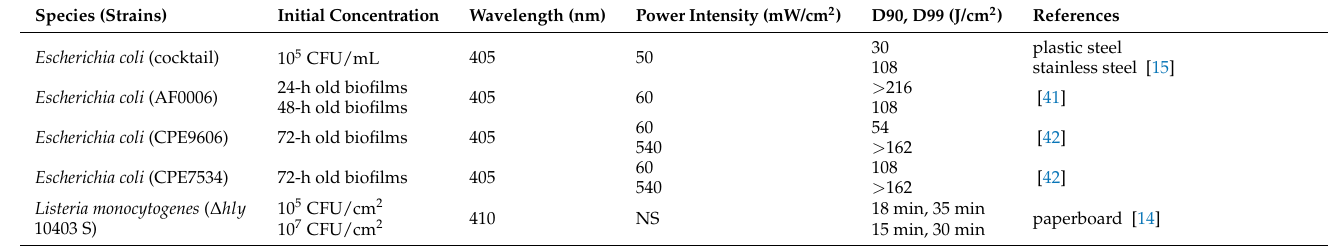
Table 2. Summary of continuous blue light inactivation of bacteria on solid surface ( D c = 1).